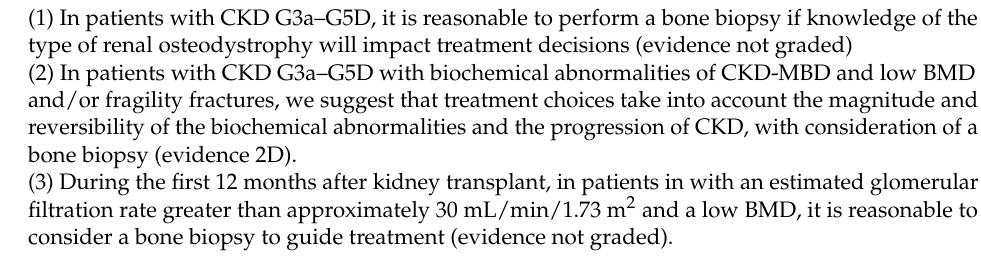
Table 2. Synthetic updated indications for bone biopsy in